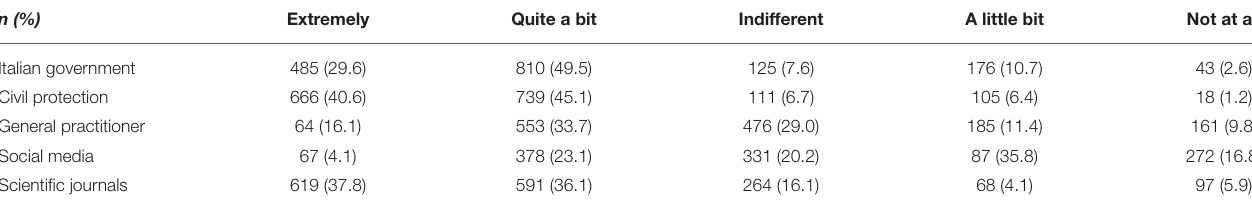
TABLE 2 | Confidence of the responders on specific sources of information during the COVID-19 emergency. n (%) Extremely Quite a bit Indifferent A little bit Not at all